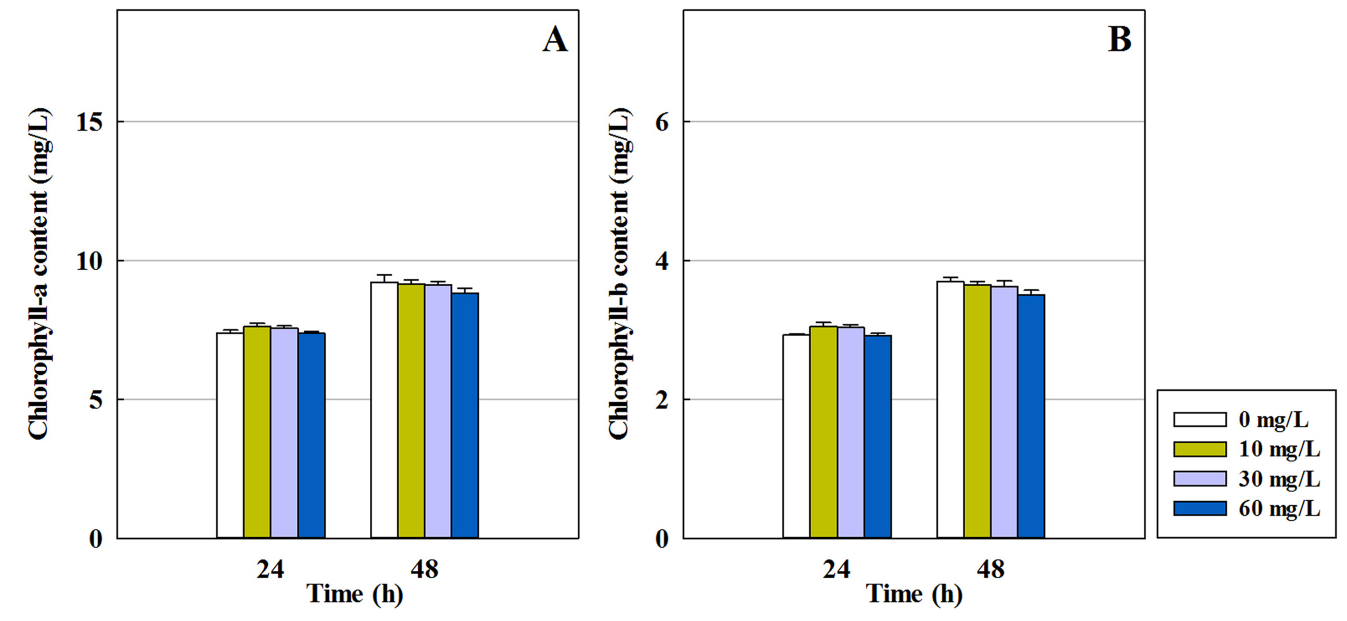
Fig 2. The chlorophyll content of C . pyrenoidosa in the first treatment batch of cefradine at three concentrations (10, 30 and 60 mg/L). (A) Chlorophyll-a content. (B) Chlorophyll-b content. Algae with under 0 mg/L of the antibiotic were used as the no treatment group.